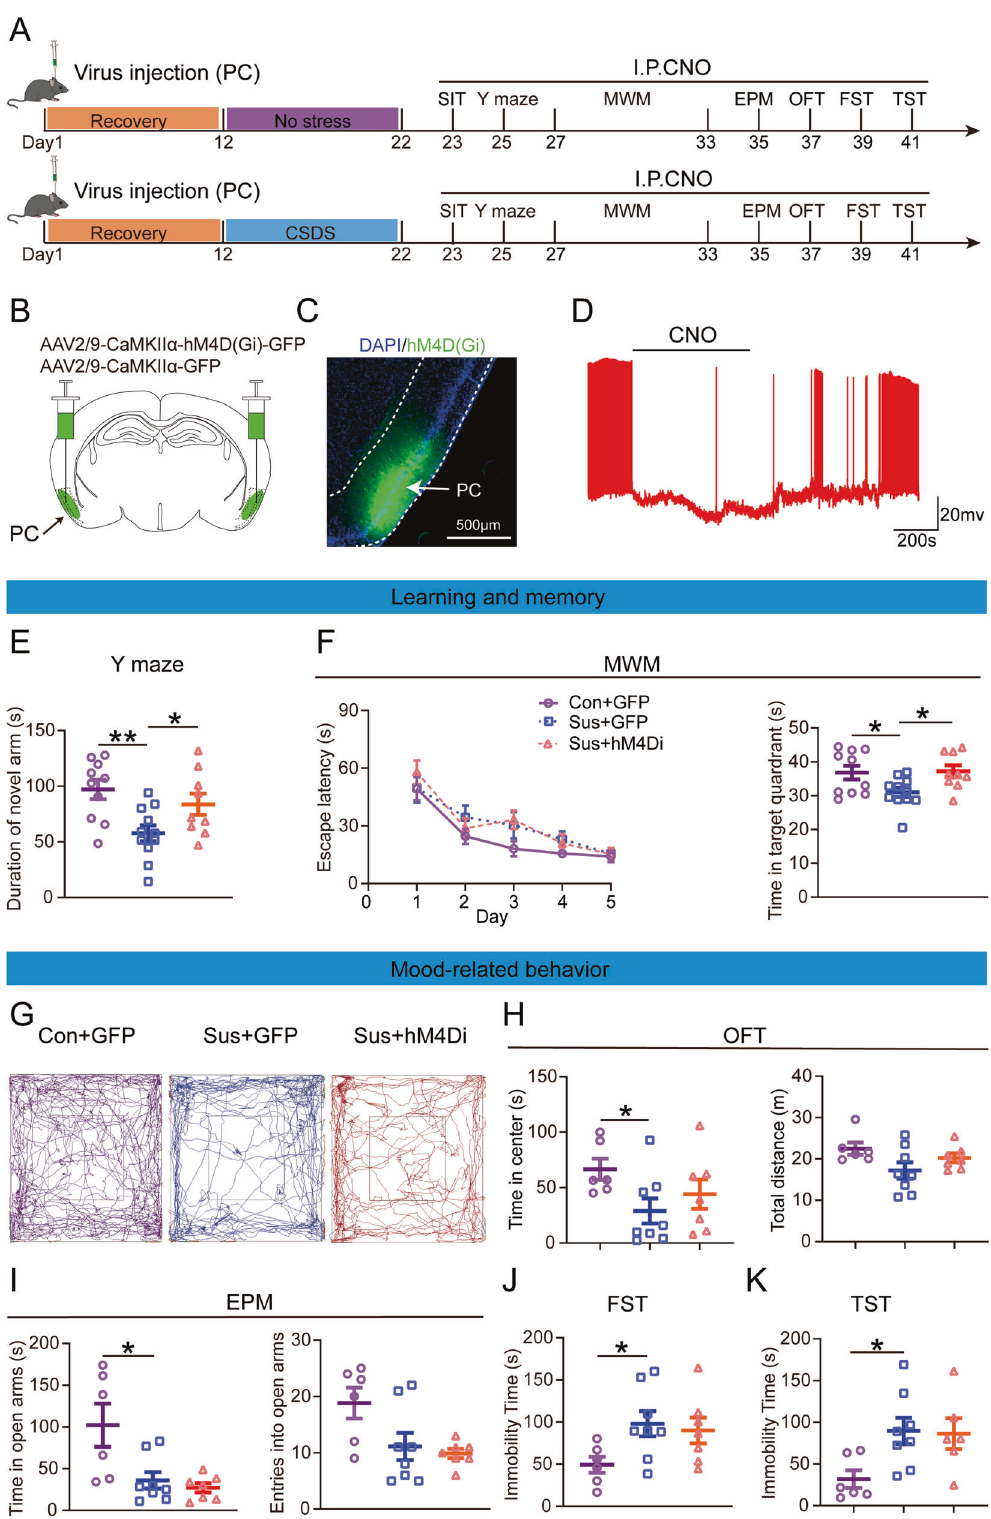
head, selective brain regions, such as PC were activated, and activity-dependent genes were expressed, and then elicit by brief tonic-clonic seizures [63, 64]. In addition, adverse effects such as cognitive and memory de fi cits have been reported after